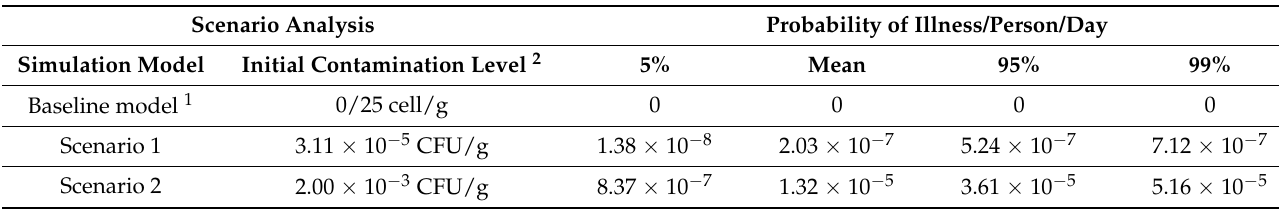
Table 3. Scenario analysis of Salmonella spp. exposure.